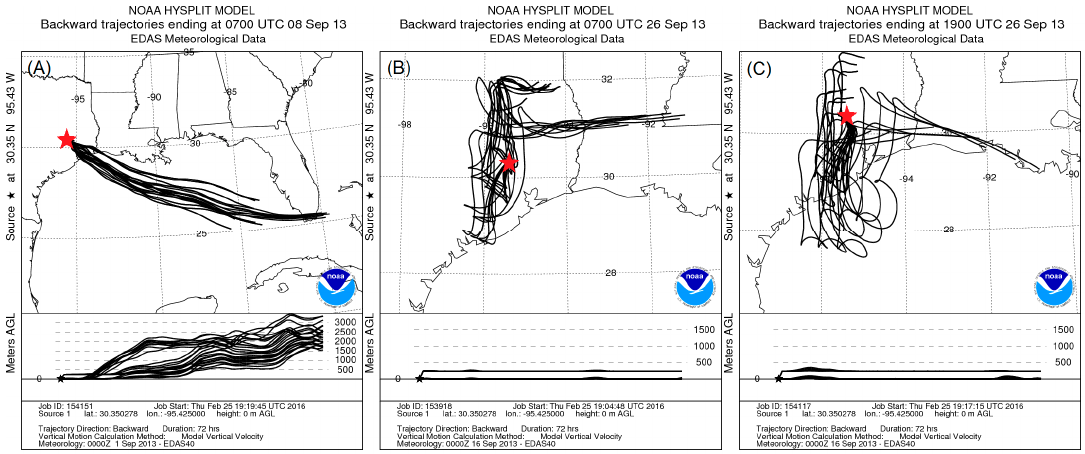
Figure 5. HYSPLIT 72-h back trajectories showing the differences between lower ( A ) and higher ( B ) concentration days. The low and high trajectories correspond to 2:00, 8 September and 2:00 26 September, respectively. Seventy-two-hour back trajectories are also shown for 14:00 26 September ( C ), so (B,C) show a typical 12 h difference.